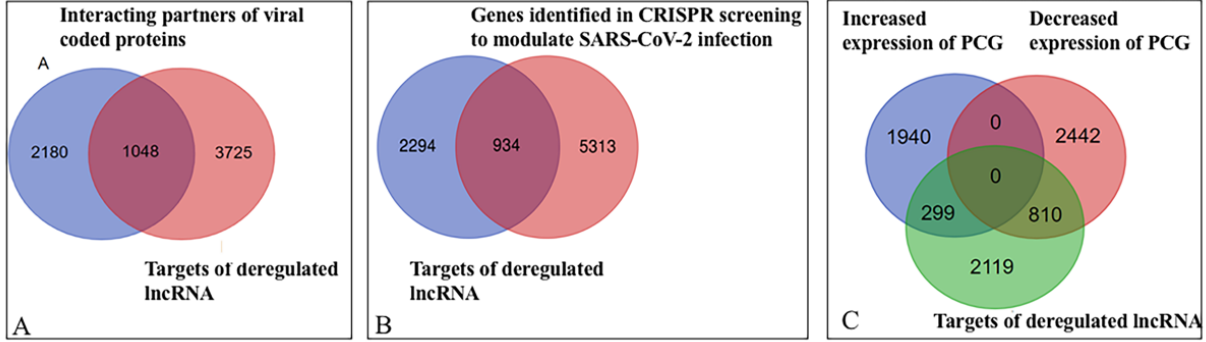
Figure 4. Common proteins among host interacting partners of SARS-CoV-2 coded proteins and targets of deregulated lncRNA ( A ), ( B ) represents the common proteins among genes/proteins identified to modulate SARS-CoV-2 infection and targets of deregulated lncRNA. ( C ) represents common PCGs altered in SARS-CoV-2 infected cells or in tissues from COVID-19 and targets of deregulated lncRNA.